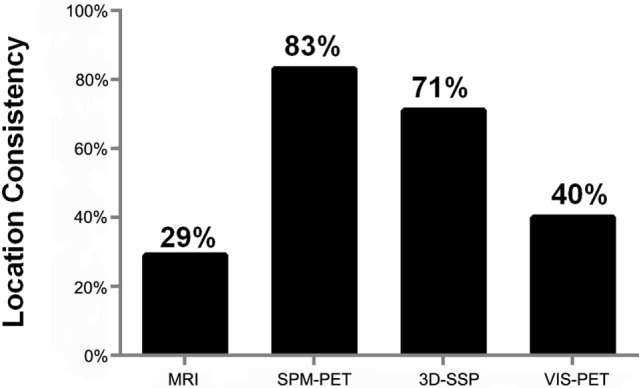
Concordance of localization for each modality relative to the presumed epileptogenic zone (PEZ).